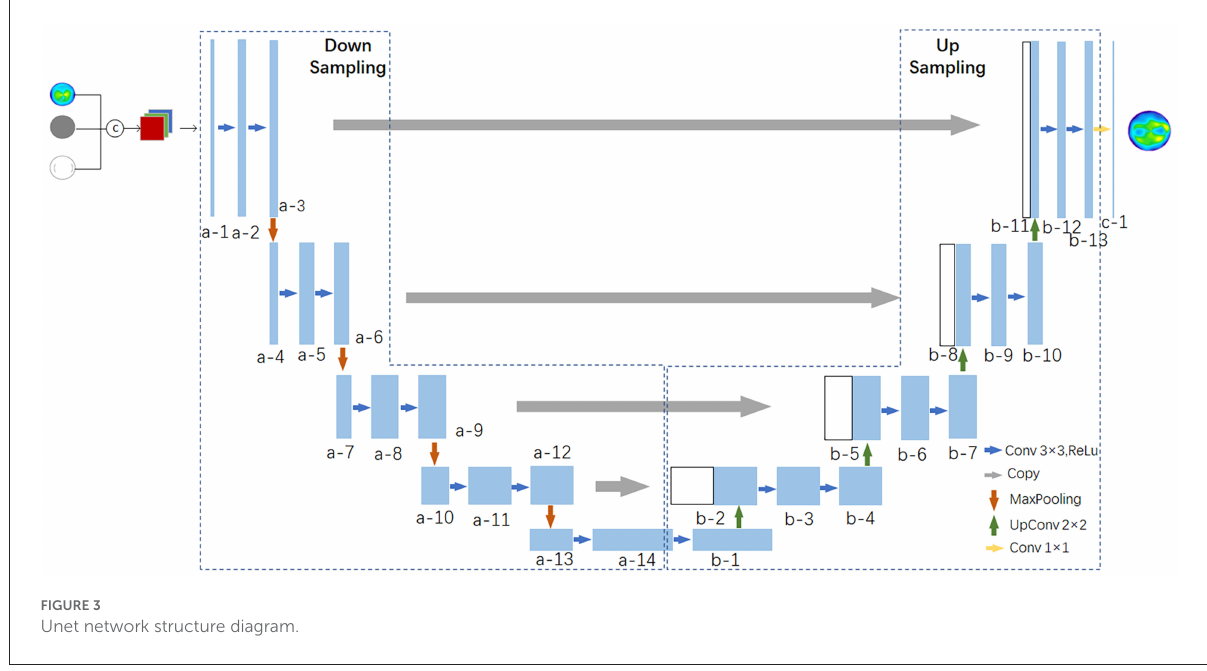
FIGURE3 Unet network structure diagram.